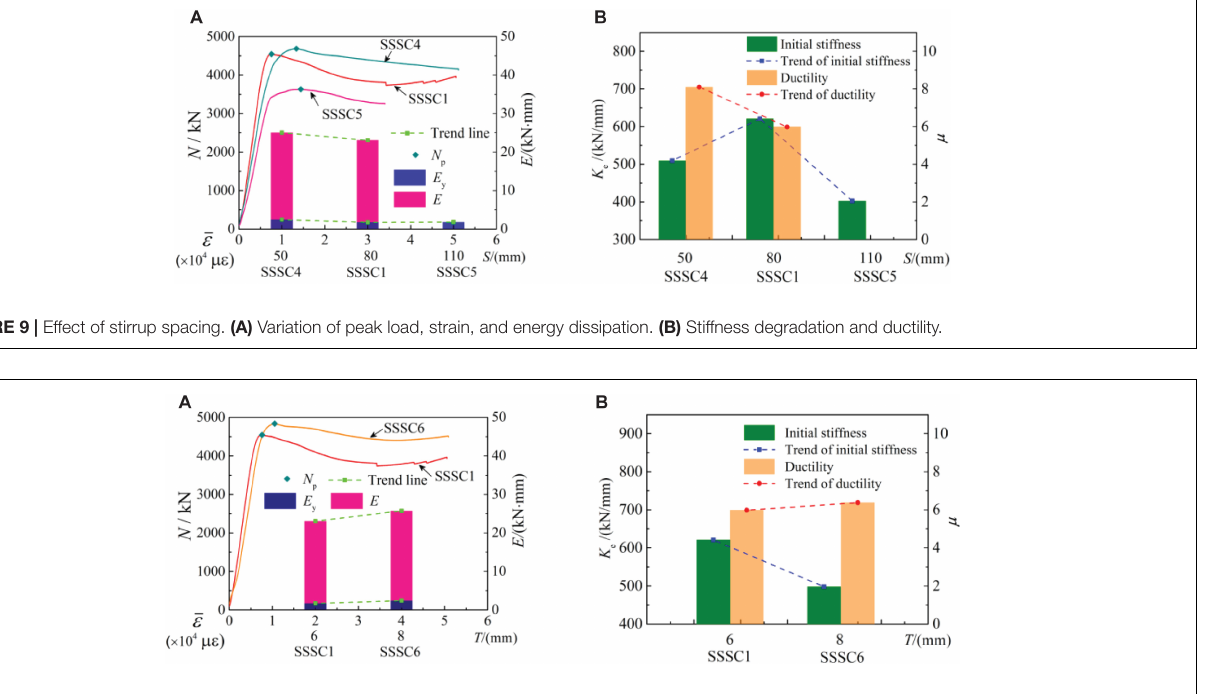
FIGURE 10 | Effect of steel tube thickness. (A) Variation of peak load, strain, and energy dissipation. (B) Stiffness degradation and ductility.